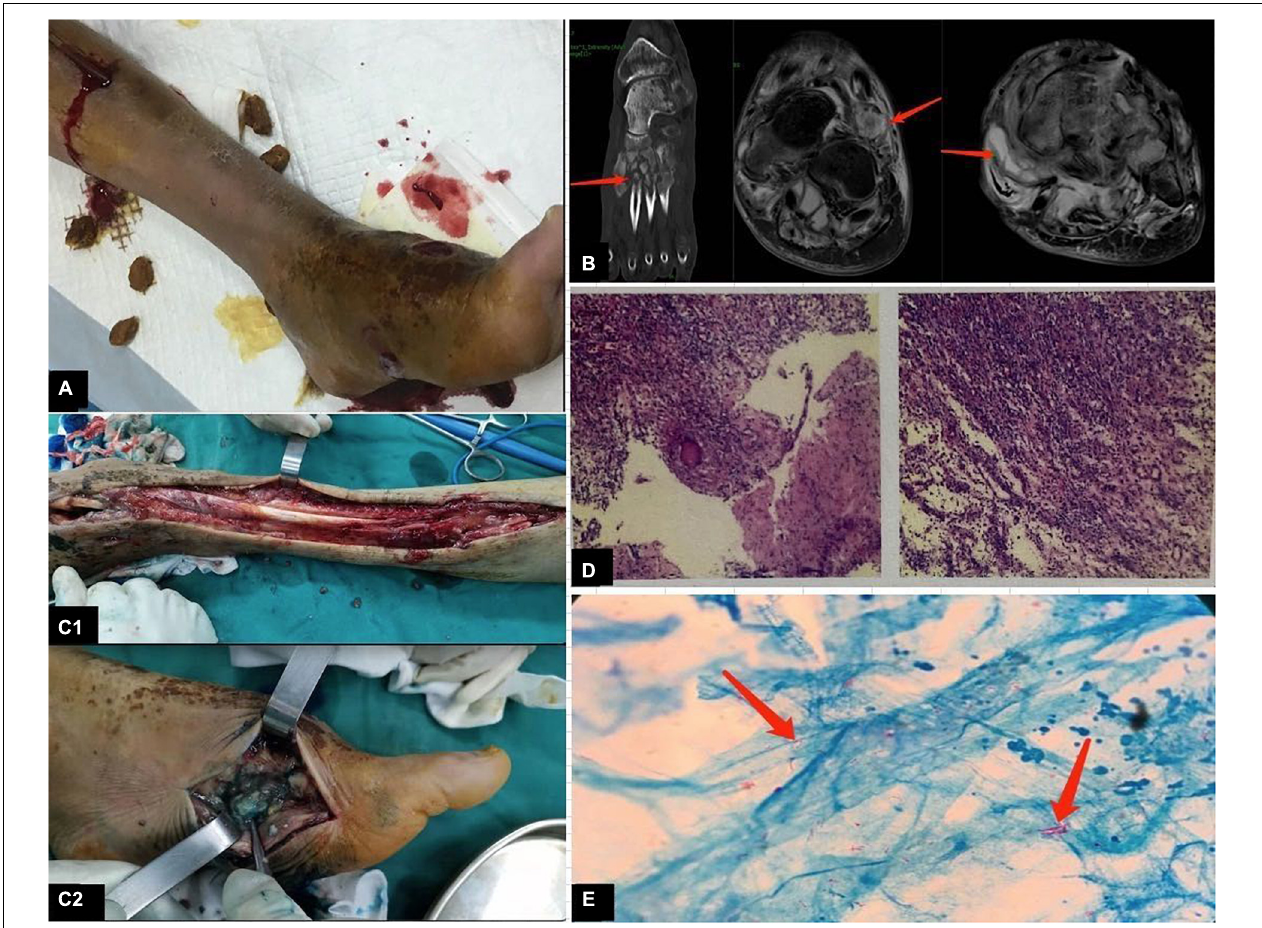
FIGURE 3 | (Case 4) (A) Clinical photographs show markedly swollen left foot, discharging sinus in the dorsum and inner side of the foot, and a skin drainage wound at the proximal end of the leg. (B) Magnetic resonance imaging demonstrates bone erosion, bone destruction, and decreased bone density in the metatarsal bone; swelling of the surrounding soft tissue structures; and sinusoidal shadows around the medial foot. (C1) The medial side of the foot reveals the dorsalis and plantar proliferative inflammatory tissues. (C2) Intraoperative photographs show local bone destruction with more inflammatory granulation tissue extending proximal to the tendon. (D) Histopathology microphotograph shows granulomatous inflammation with necrosis. (E) Intraoperative tissue samples with the presence of acid-fast bacilli